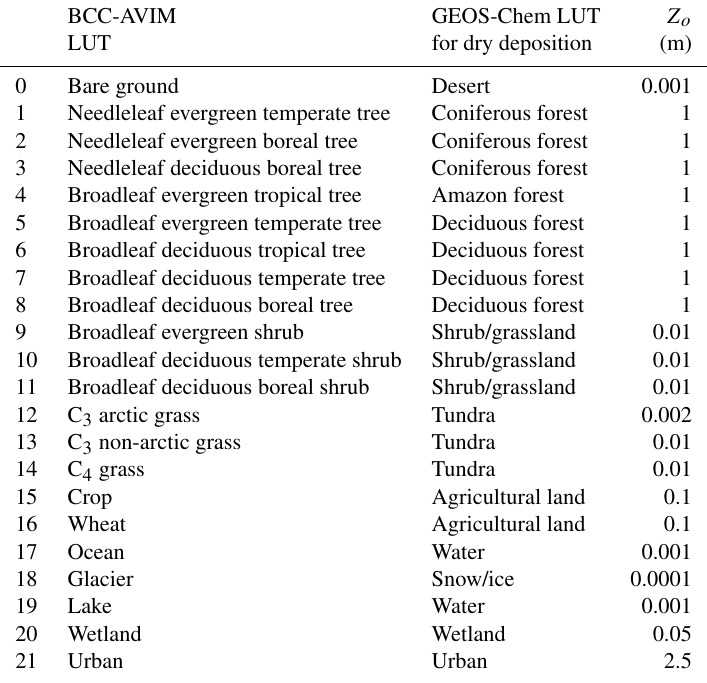
Table 1. Mapping of land use types (LUTs) used in BCC-GEOS-Chem v1.0 to the Wesely deposition surfaces for deposition. Also shown are the roughness heights ( Z o ) for each LUT. BCC-AVIM Bare ground Needleleaf evergreen temperate tree Coniferous forest Needleleaf evergreen boreal tree Coniferous forest Needleleaf deciduous boreal